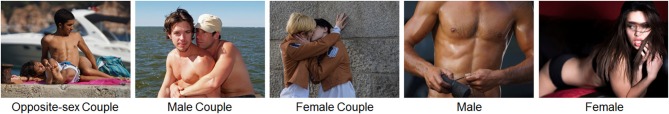
A sample image from each category. All images were obtained from Flickr and were published under a Creative Commons license. Credits (from left to right): Charles Roffey, CC BY-NC-SA 2.0; David Shankbone, CC BY 2.0; Georgie Pauwels, CC BY 2.0; Charles Roffey, CC BY-NC-SA 2.0; Lies Thru a Lens, CC BY 2.0. For license terms see: CC BY 2.0 (https://creativecommons.org/licenses/by/2.0/); CC BY-NC-SA 2.0 (https://creativecommons.org/licenses/by-nc-sa/2.0/).